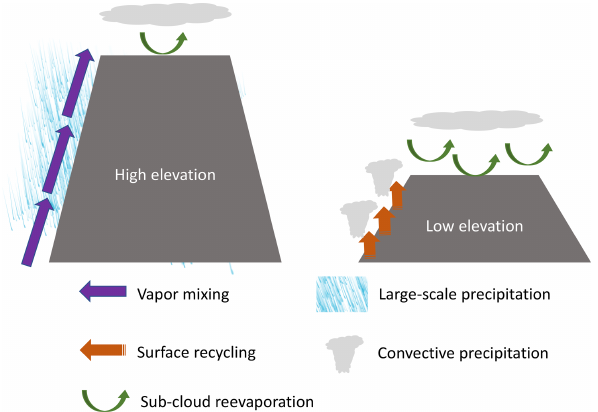
Figure 17. A sketch showing dominant sources/sinks of 18 O in the Himalayas and dominant process impacting δ 18 O p on the Tibetan Plateau for high- and low-elevation